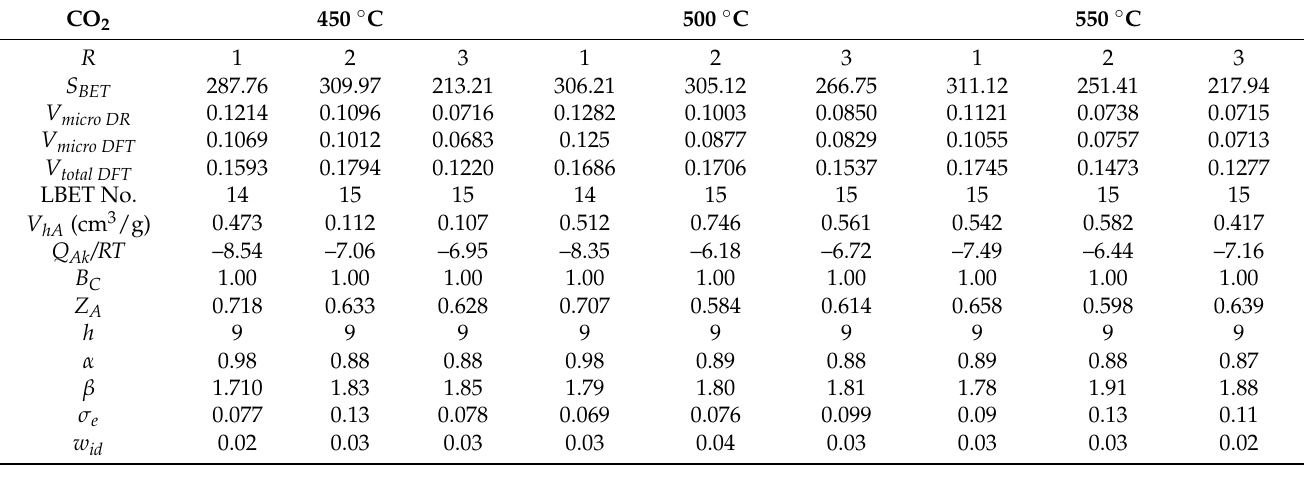
Table 1. The results of the analysis of a porous structure of activated carbons, based on carbon di- oxide adsorption isotherms, using the BET, T-plot, DR, and LBET methods.